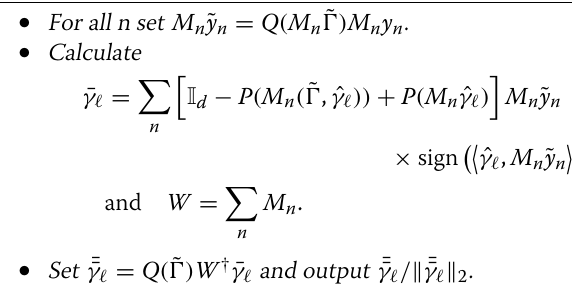
Algorithm 3 (low-rank atom recovery from